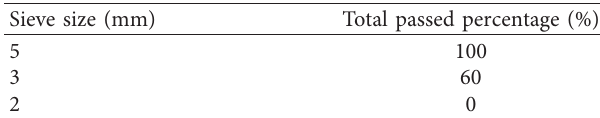
Table 2: Rubber particle size distribution.